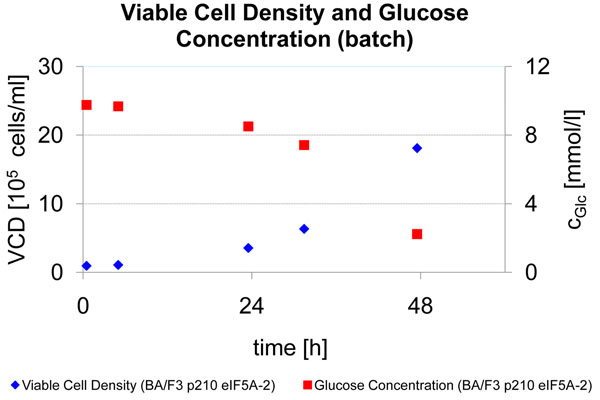
Vstart = 5090 mL, max. viable cell density in exponential growth after 39.5 hours VCDmax = 18.1·105 cells mL-